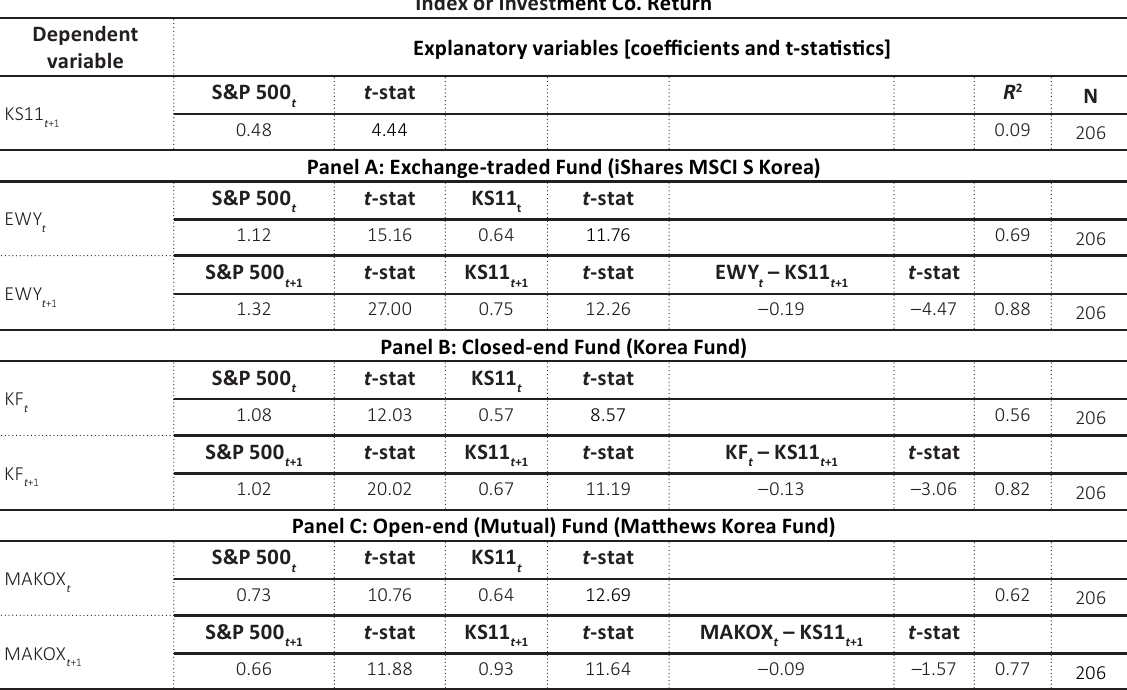
Table 2. Regression estimates for the determinants of South Korean equity investment company returns using daily returns for 2006–2010 for the days when the S&P 500 daily return was –1% or lower Index or Investment Co.